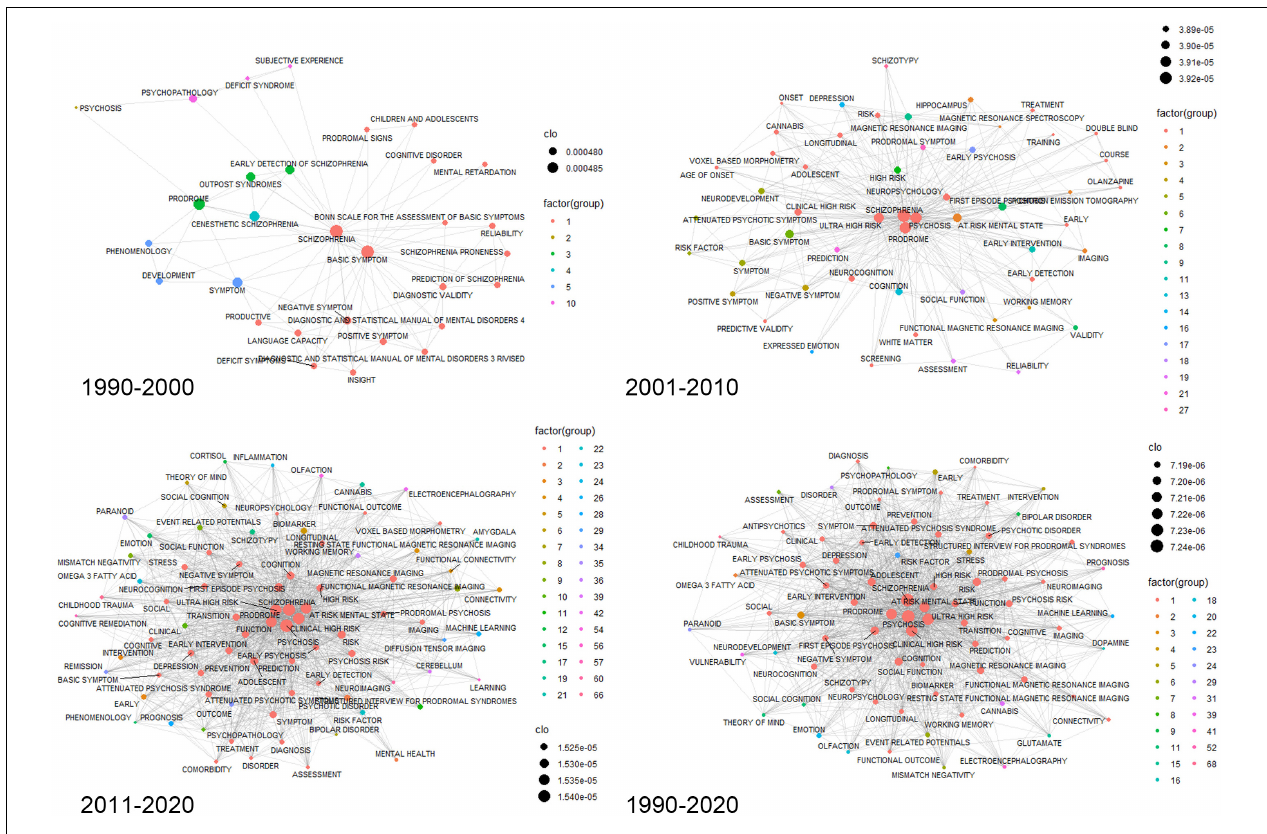
FIGURE 5 | Keyword co-occurrence network. Centrality measure used is closeness